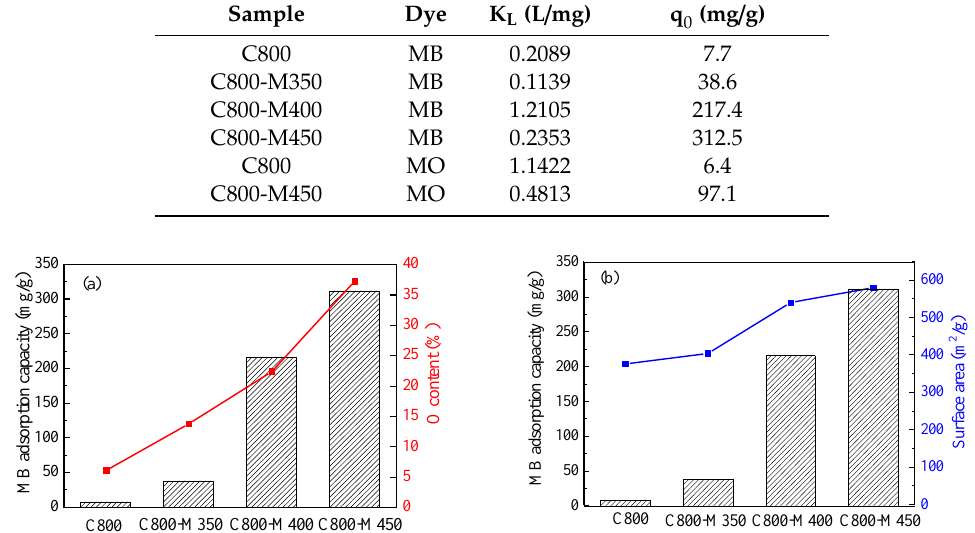
Table 3. The Langmuir isotherm parameters for the adsorption of organic dyes onto as-prepared carbons.